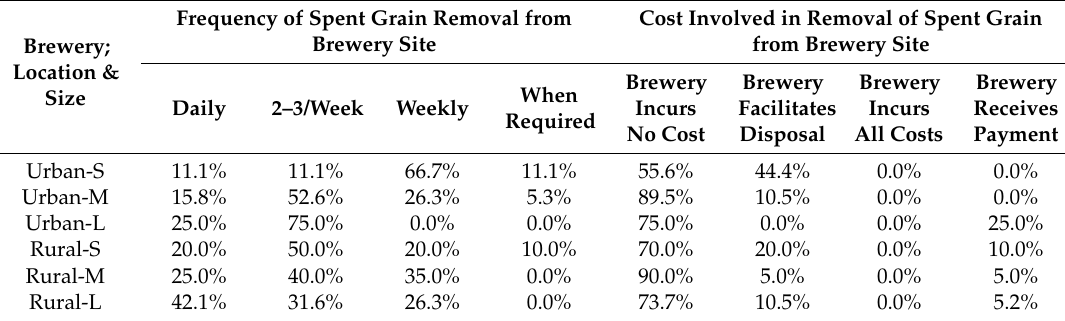
Table 1. Frequency of spent grain removal and costs incurred, by brewery location and